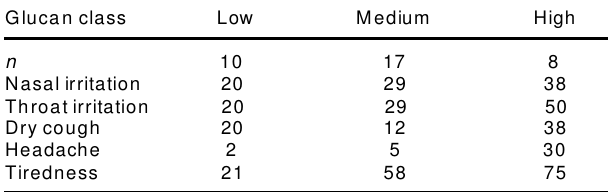
Table 1. Airborne classes of (1 ® 3)- b - D -glucan in relation to ex- tent of symptoms (percentage of subjects expressing symptoms) Glucan class